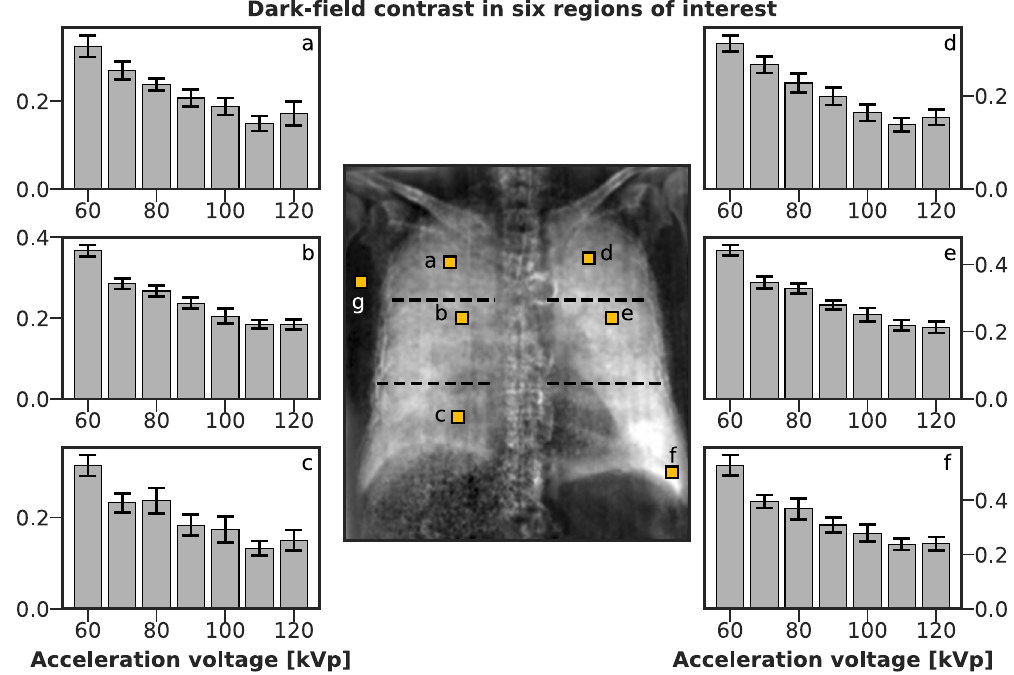
Figure 5. Dark-field contrast as a function of tube voltage in six ROIs ( a – f ), with respect to an ROI in the vicinity of the lung ( g ). Each ROI is a 30 × 30 pixel square, placed at highlighted locations in the central overview image. Graphs correspond to ROIs with the same letter. ROIs were placed such that ribs were avoided. Contrast decreases towards higher tube voltages in all lung zones. The horizontal dashed lines in the overview image approximate the extent of the six lung zones assumed in the reader